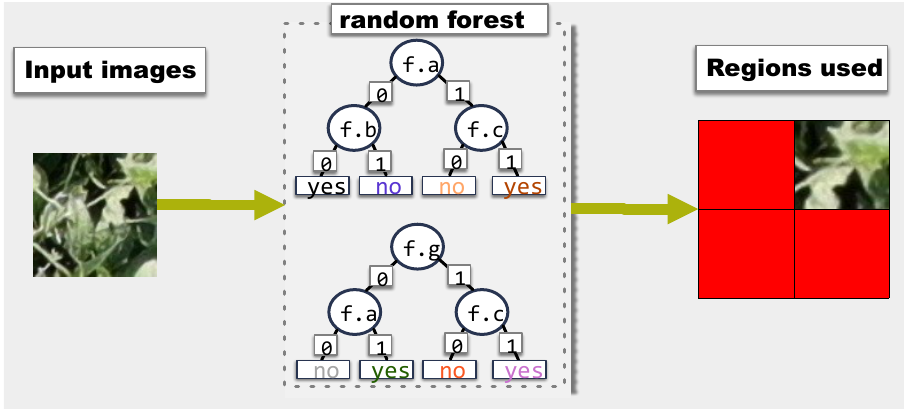
Figure 6. Example of feature coverage on the same input as Figure 5, but considering only whether any pixel in any of the four regions is